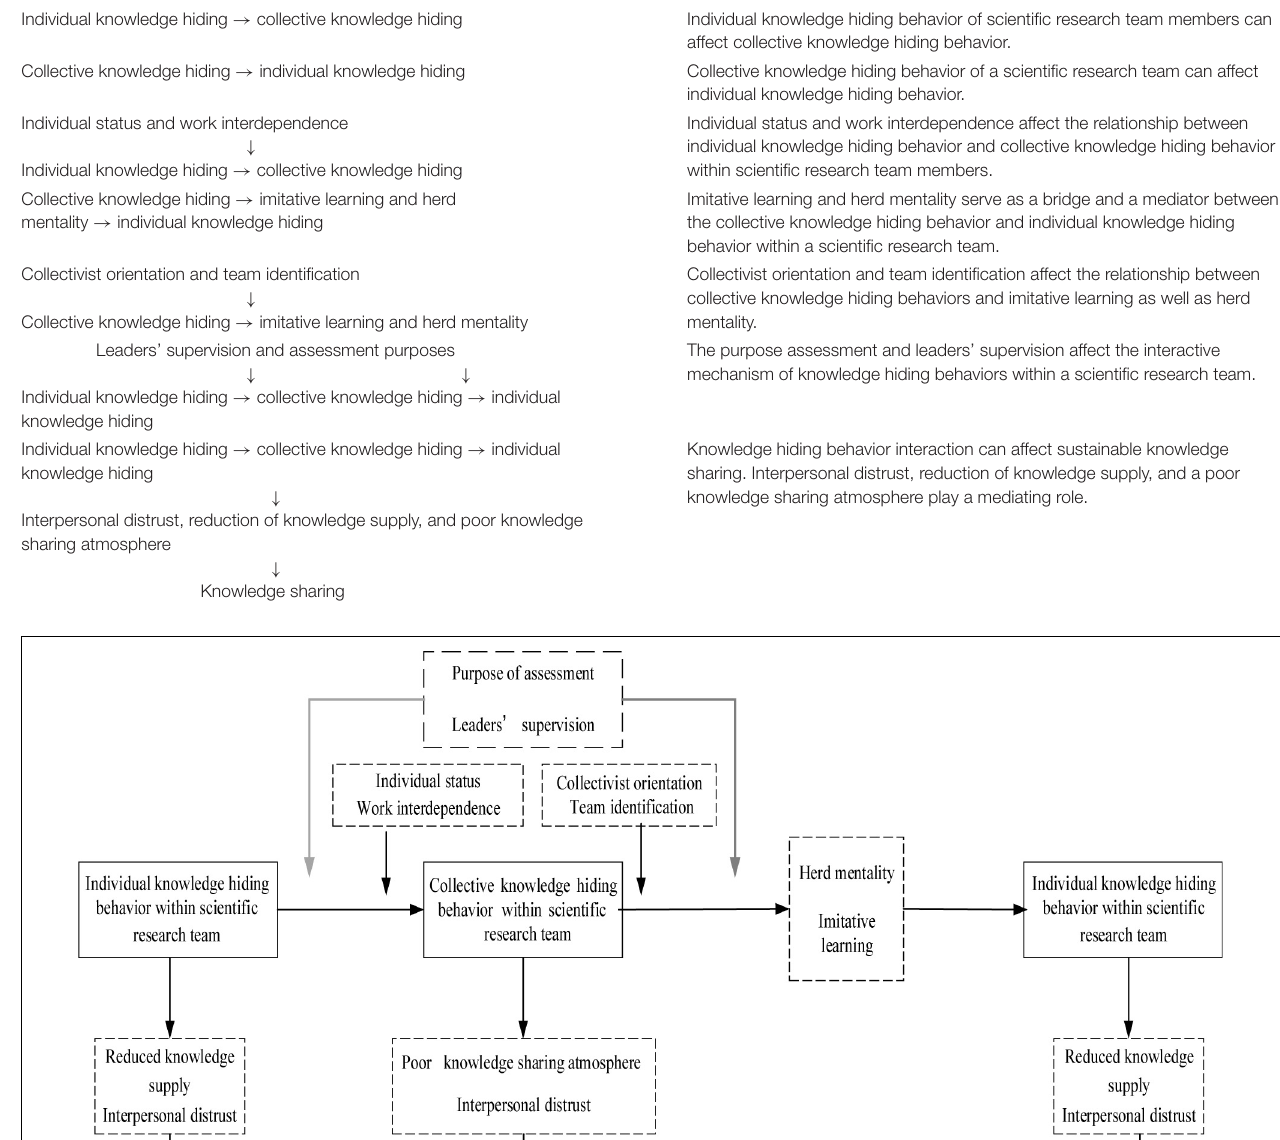
which is consistent with the findings of research on social exchange theory; that is, the most important reason for the failure of knowledge sharing is insufficient knowledge